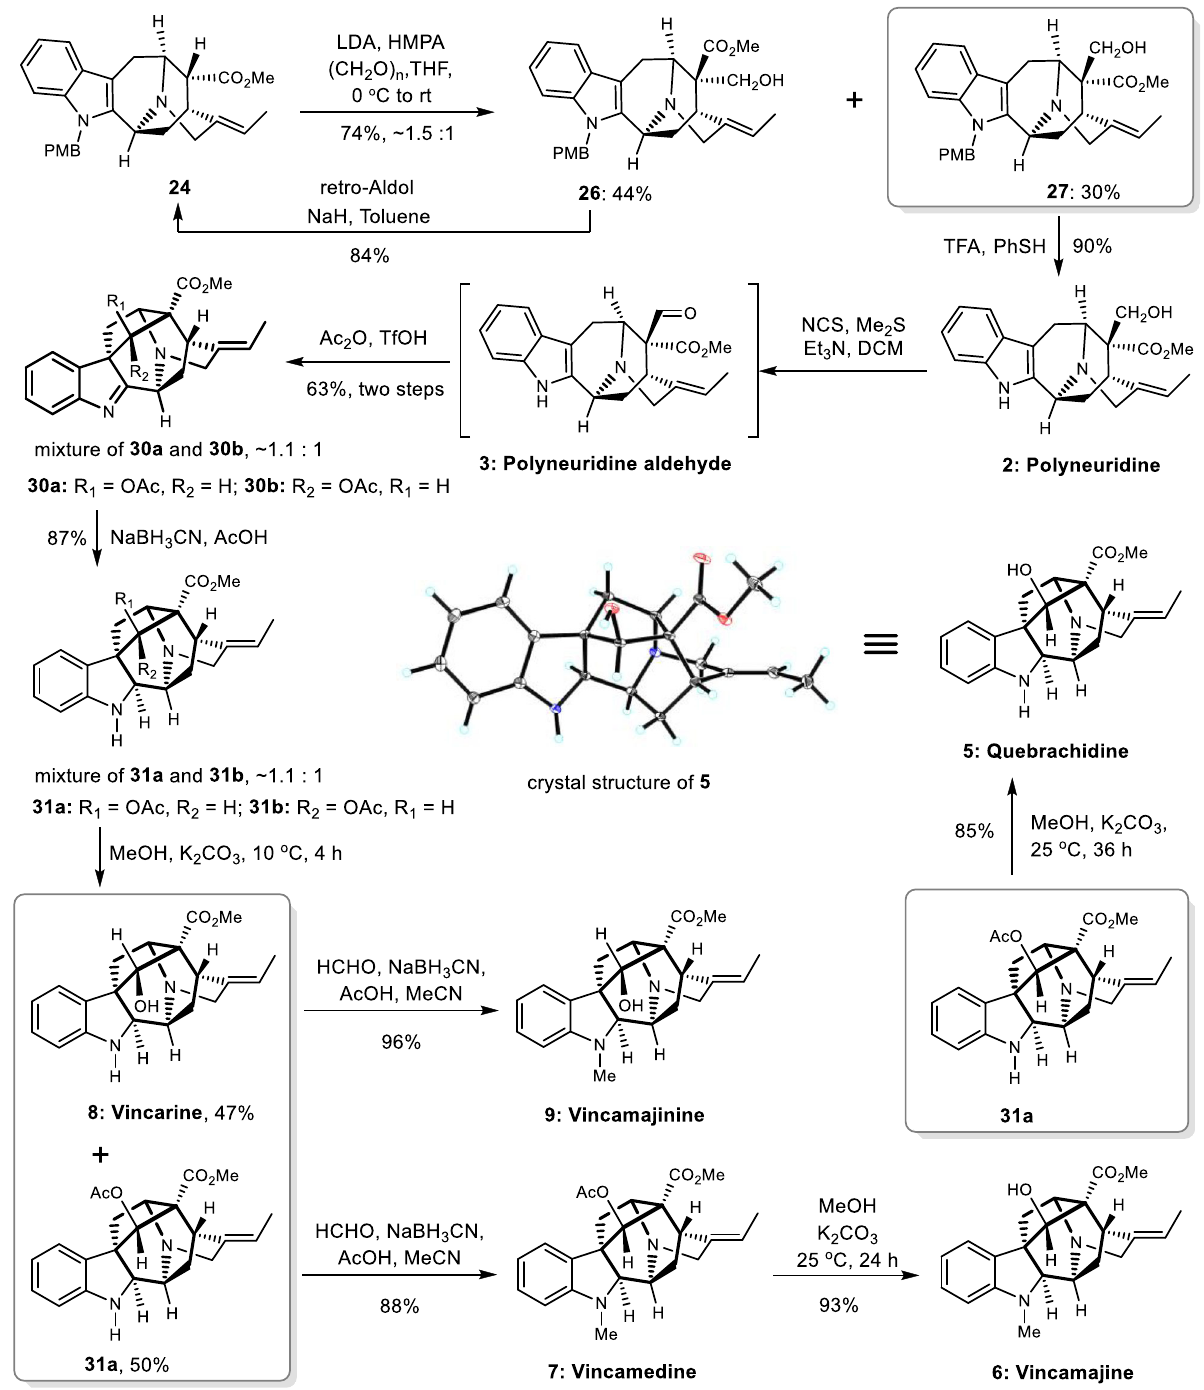
Fig. 6 Synthesis of ajmaline type alkaloids. Quebrachidine, vincarine, vincamedine, and vincamajine were synthesized for the fi rst time. NCS N -